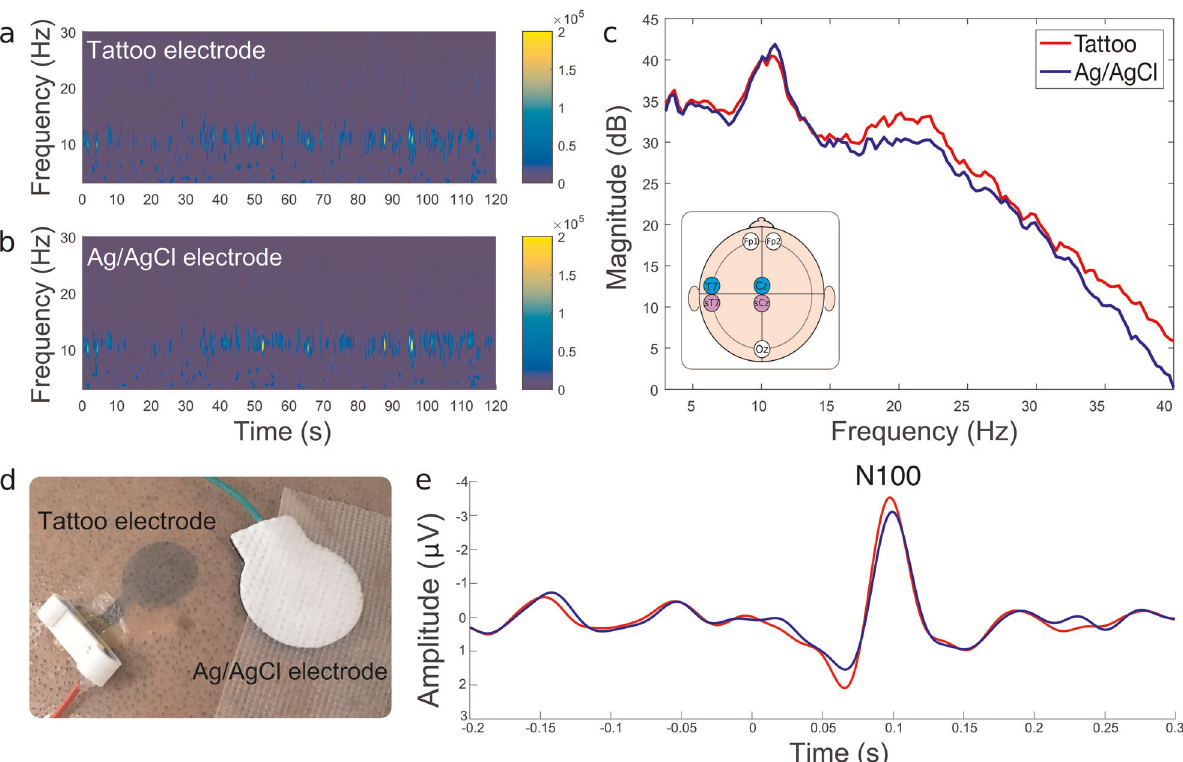
Fig. 3 Comparison of recording performances between TTEs and Ag/AgCl electrodes. a , b Time-frequency plot of alpha wave recordings, with visible 10 Hz activity obtained with tattoo ( a ) and AgAgCl ( b ) electrodes. c Superimposed PSD (dB) during alpha wave recordings from TTEs — in red, and Ag/AgCl electrodes — in blue. The insert at the bottom left shows the electrodes placement with used derivation (Tz – Cz, in light blue for the TTE, and sT7-sCz for the Ag/AgCl electrodes in light violet). d Picture of two electrodes in Cz position on the head of the participant. e Auditory Evoked Potential recorded with both TTEs (red) and Ag/AgCl electrodes (blue), with N100- an auditory evoked potential